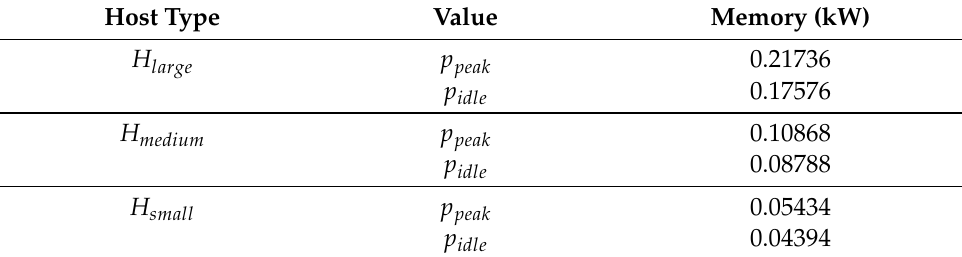
Table 3. Memory power parameters.